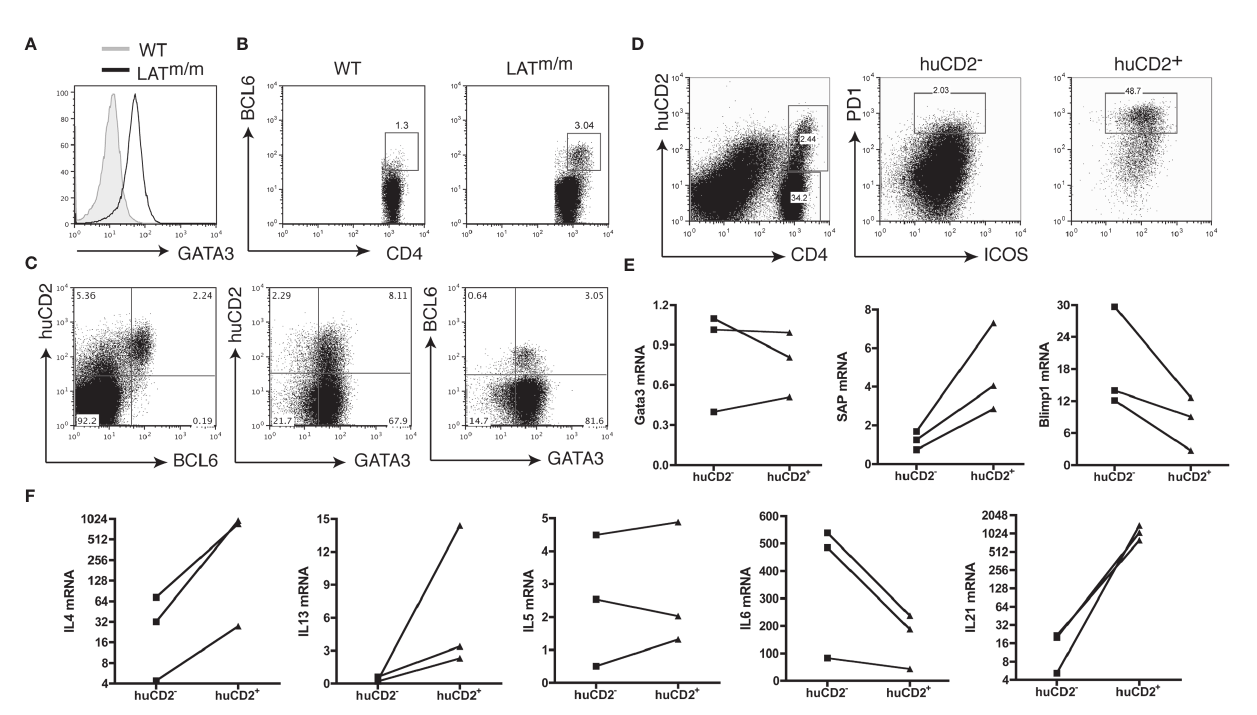
FIGURE 2 | IL4-producing CD4 + T cells in LATY136F mice are Tfh cells. (A) Intracellular staining of GATA3. Cells were pre-gated on splenic CD4 + T cells. (B) BCL6 expression in CD4 + T cells from the spleens of WT and LAT m/m mice. (C) Flow cytometry analysis of huCD2, GATA3, and BCL6 expression on CD4 + T cells from IL4 KN2/+ LAT m/m mice. (D) ICOS and PD1 expression on huCD2 + and huCD2 - CD4 + T cells from IL4 KN2/+ LAT m/m mice (6-8 weeks old). (E, F) Real-time PCR analysis. RNA levels of GATA3, SAP, Blimp1, and different cytokines from sorted huCD2 + and huCD2 - CD4 + T cells from 3-month-old IL4 KN2/+ LAT m/m mice were normalized to b -actin. Connected lines indicate sorted populations from the same mouse. Data are representative of 2-5 independent